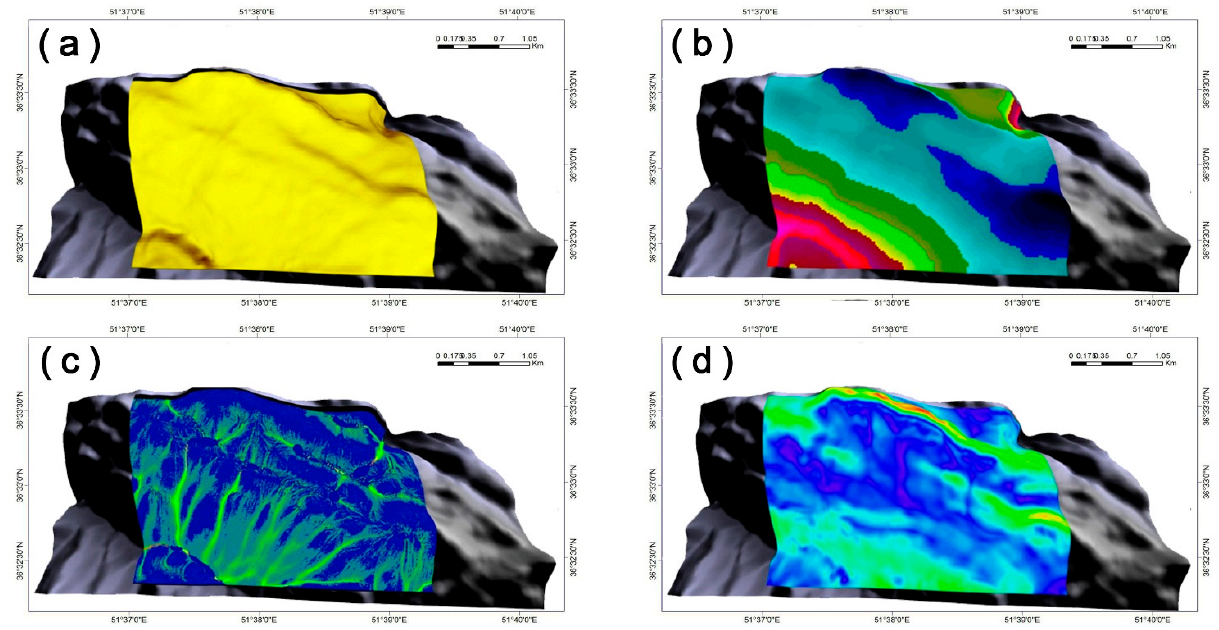
Figure 3. Model-generated abiotic surfaces of ( a ) growing season cumulative cloud-free solar radiation (MJ m − 2 ), ( b ) mean seasonal air temperature ( ◦ C), ( c ) topographic wetness index (TWI; unitless), and ( d ) wind velocity within the study area (m s − 1 ).